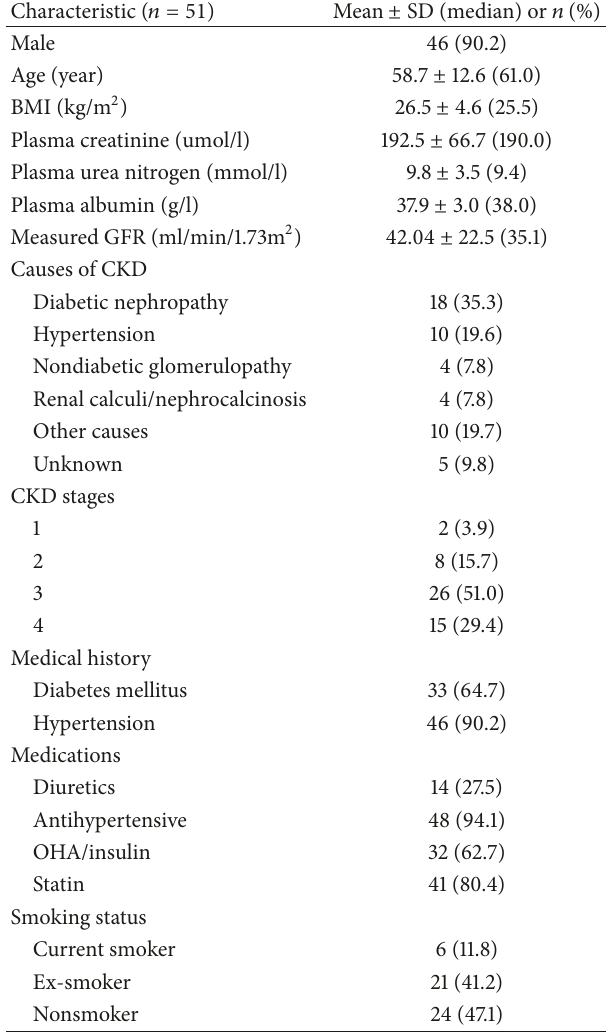
Table 2: Baseline characteristics of